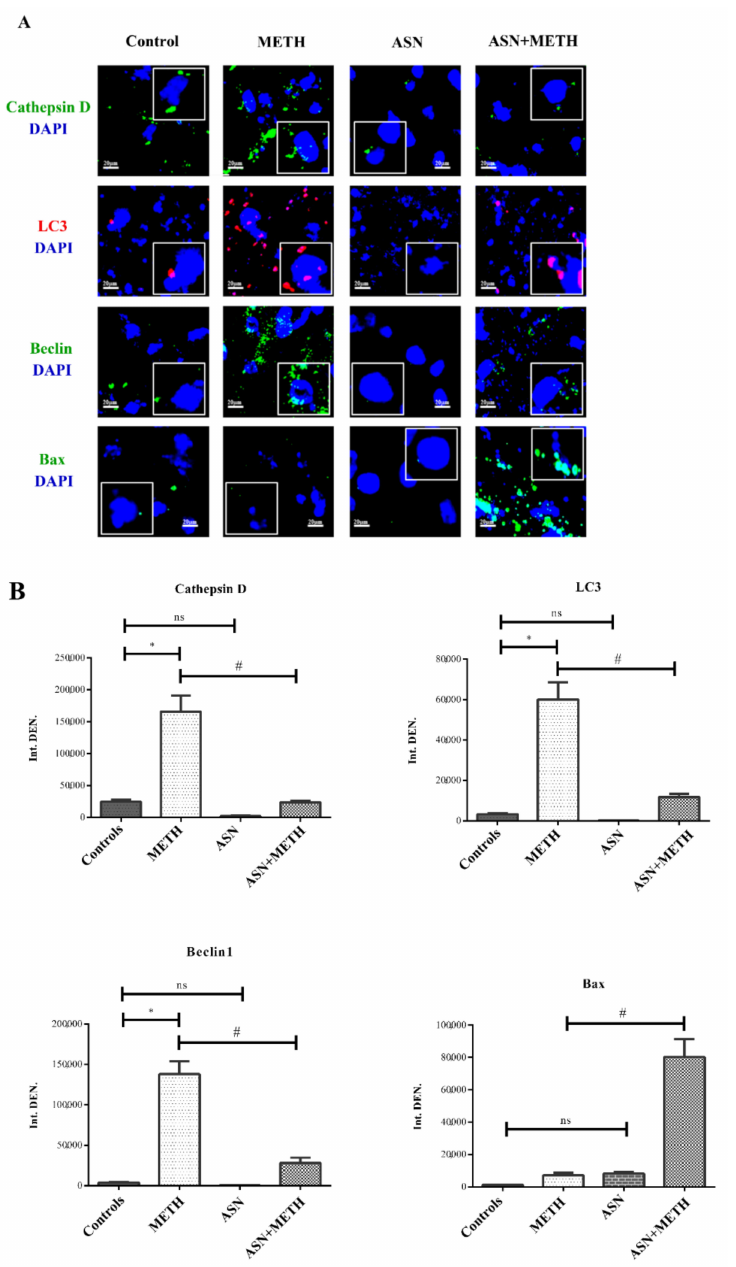
Figure 1. ASN impairs autophagy and worsens METH toxicity. ( A ) Representative pictures from midbrain tegmentum showing immunofluorescence for autophagy-related proteins such as LC3II (the lipidated isoform of the protein hallmark protein of autophagosomal membrane), Beclin1 (an interactor of PI3KC3, which promotes autophagosome biogenesis) and Cathepsin-D (a lysosomal protease). In addition, immunofluorescence for the apoptosis-related antigen Bax is shown rep- resentatively. Pictures are obtained from mice administered either saline, METH, ASN and the combination ASN + METH. The insert magnifies specific puncta (or fluorescent aggregates). Arrows indicate each specific antigen. ( B ) Graphs report densitometry for each protein. Data are given as Arbitrary Units ± S.D. and represent the average IntDEN of five microscopic fields randomly chosen (IntDEN = integrated density is the product of Area of selected cell X Mean fluorescence calculated with the software ImageJ). ns = not significant. * p < 0.05 compared with Controls; # p < 0.05 compared with METH. Scale bar = 20 µ